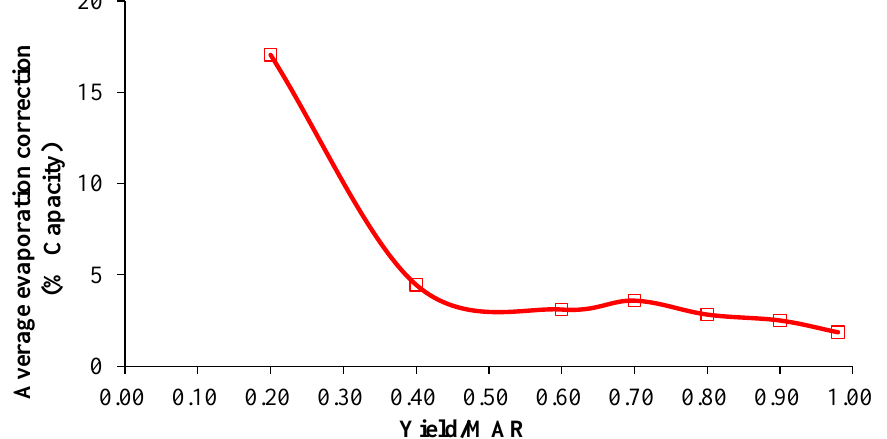
Figure 8. Evaporation correction as % of capacity (average for Pong and Bhakra reservoirs with the nonlinear H–S model).